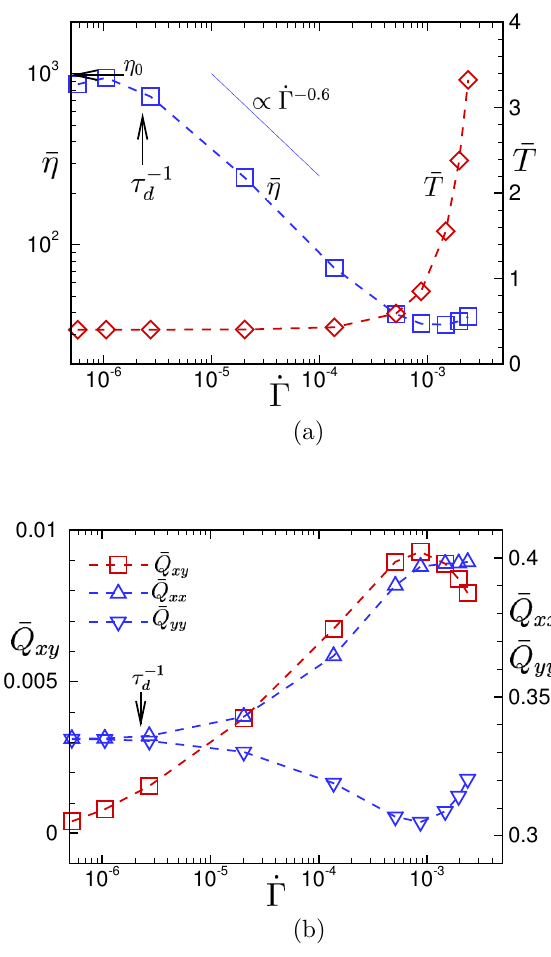
Figure 6. ( a ) The apparent viscosity ¯ η and the spatial average of the local temperature ¯ T against the gross shear rate ˙ Γ , which is defined by the ratio of the upper-wall velocity v w to the channel width H , ˙ Γ = v w / H . ( b ) The spatial average of the local bond-orientation tensor ˙ Γ . The viscosity of the model polymeric liquid in the quiescent state η disengagement of entangled polymer chains in the reptation dynamics τ − 1